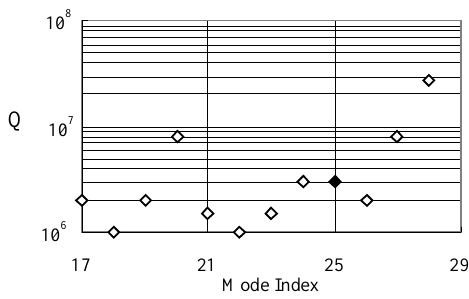
FIG. 12. The computed quality factors for modes from the (cid:53) p (cid:121) (cid:55) , (cid:54) p (cid:121) (cid:55) , and p groups: (cid:115) (cid:114) (cid:100) accelerating mode, (cid:115) (cid:101) (cid:100) other modes.